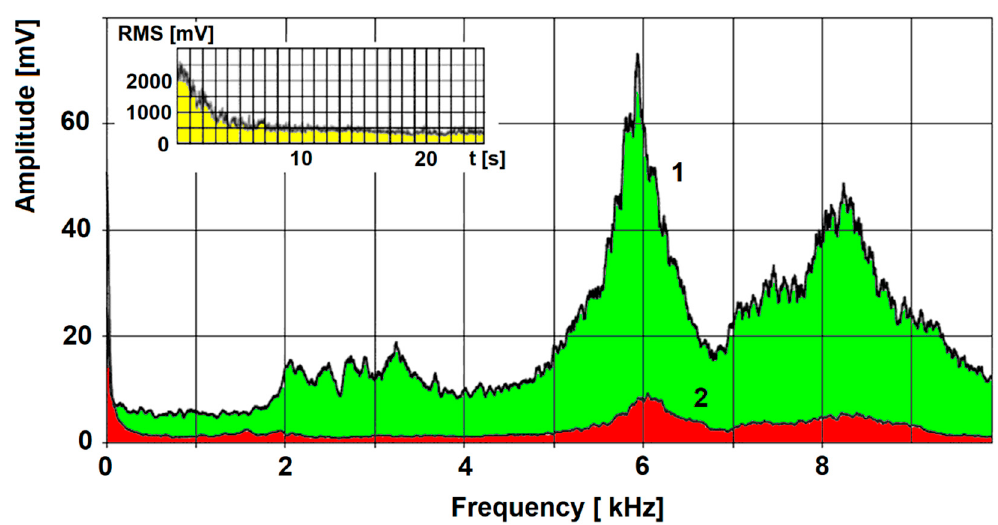
Figure 5. High-frequency spectra of vibroacoustic signals for AISI 2024: (1) is at the moment of wire penetration; (2) at the moment of the discharge gap formation; RMS-t diagram inset presents the spectra of the signal at the moment of wire penetration.